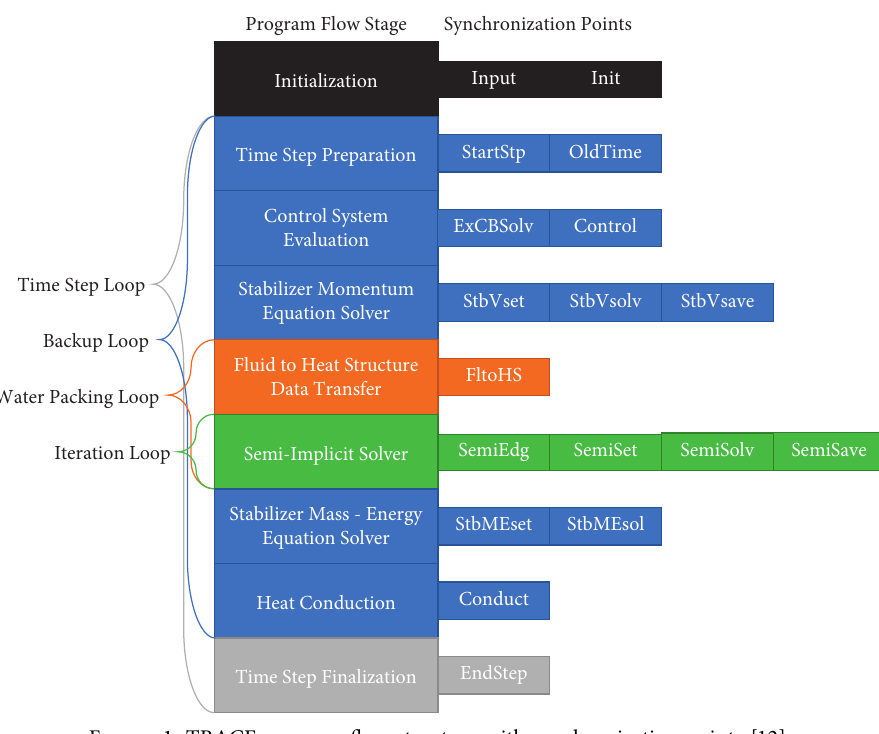
Figure 1: TRACE program flow structure with synchronization points